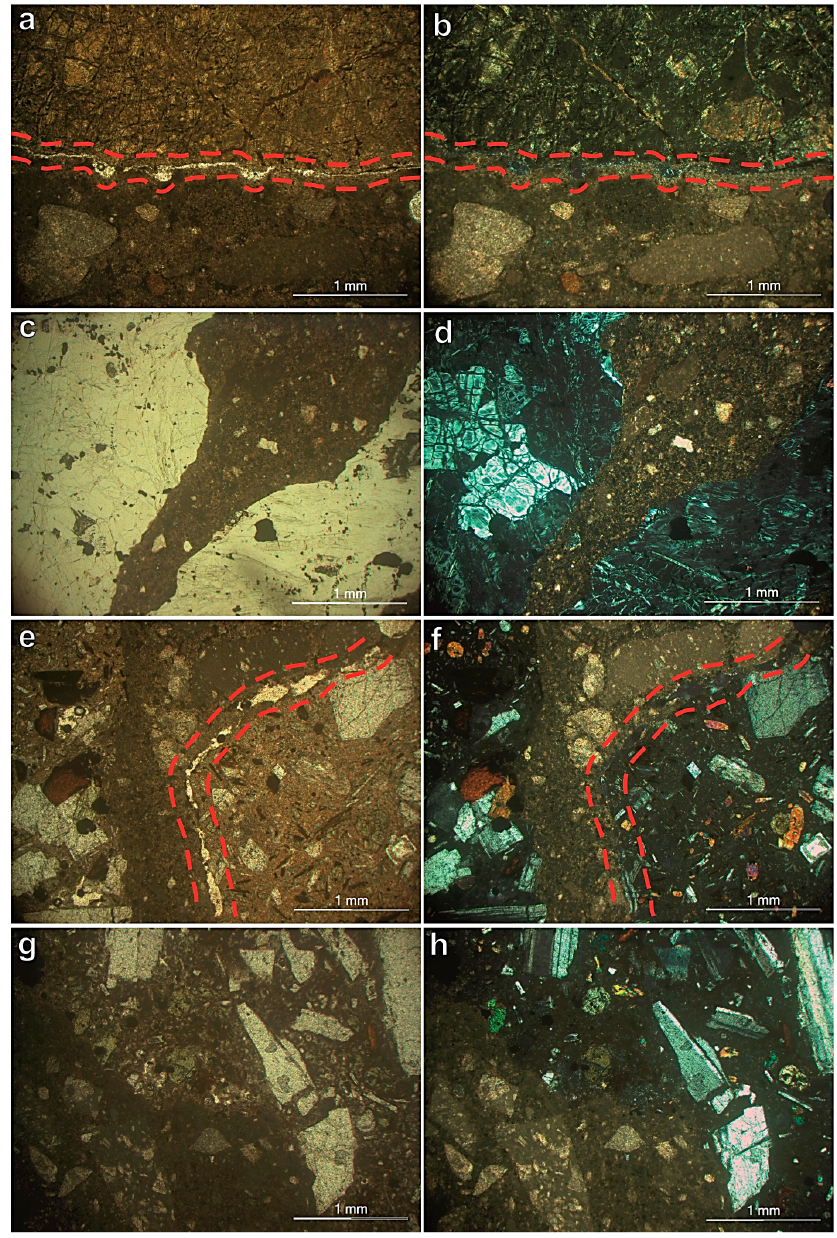
Figure 7. Photomicrographs of representative tested concretes: ( a ), ( b ) bad cohesion between the cement paste and the serpentinite aggregate particle (sample BE.103, PPL, XPL); ( c ), ( d ) good cohesion between the cement paste and the serpentinite aggregate particle (sample BE.01, PPL, XPL); ( e ), ( f ) bad cohesion between the cement paste and the andesite aggregate particle (sample BE.82, PPL, XPL); ( g ), ( h ) good cohesion between the cement paste and the andesite aggregate particle (sample BE.88, PPL, XPL). Red lines constrain the contacts between aggregate particles and cement